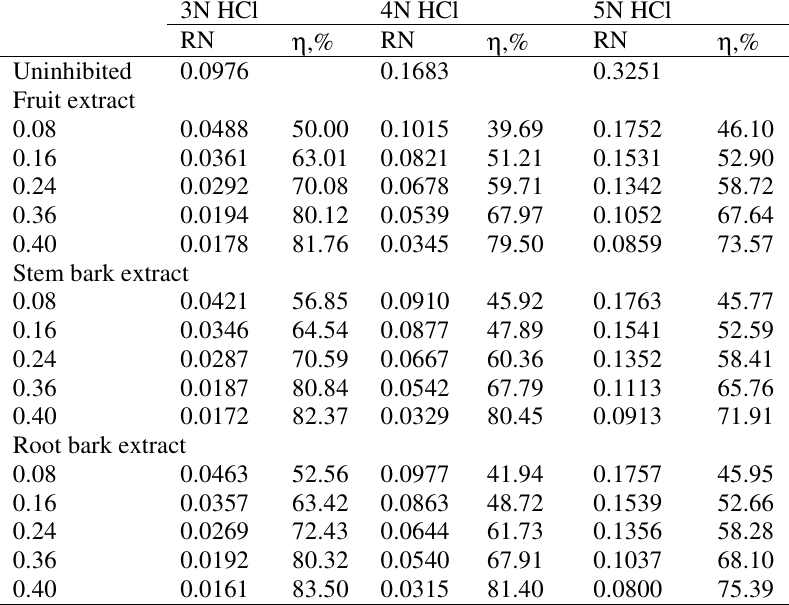
6 . Reaction number and inhibition efficiency for aluminium in sulphuric acid solution with given inhibitor addition at room temperature for Capparis